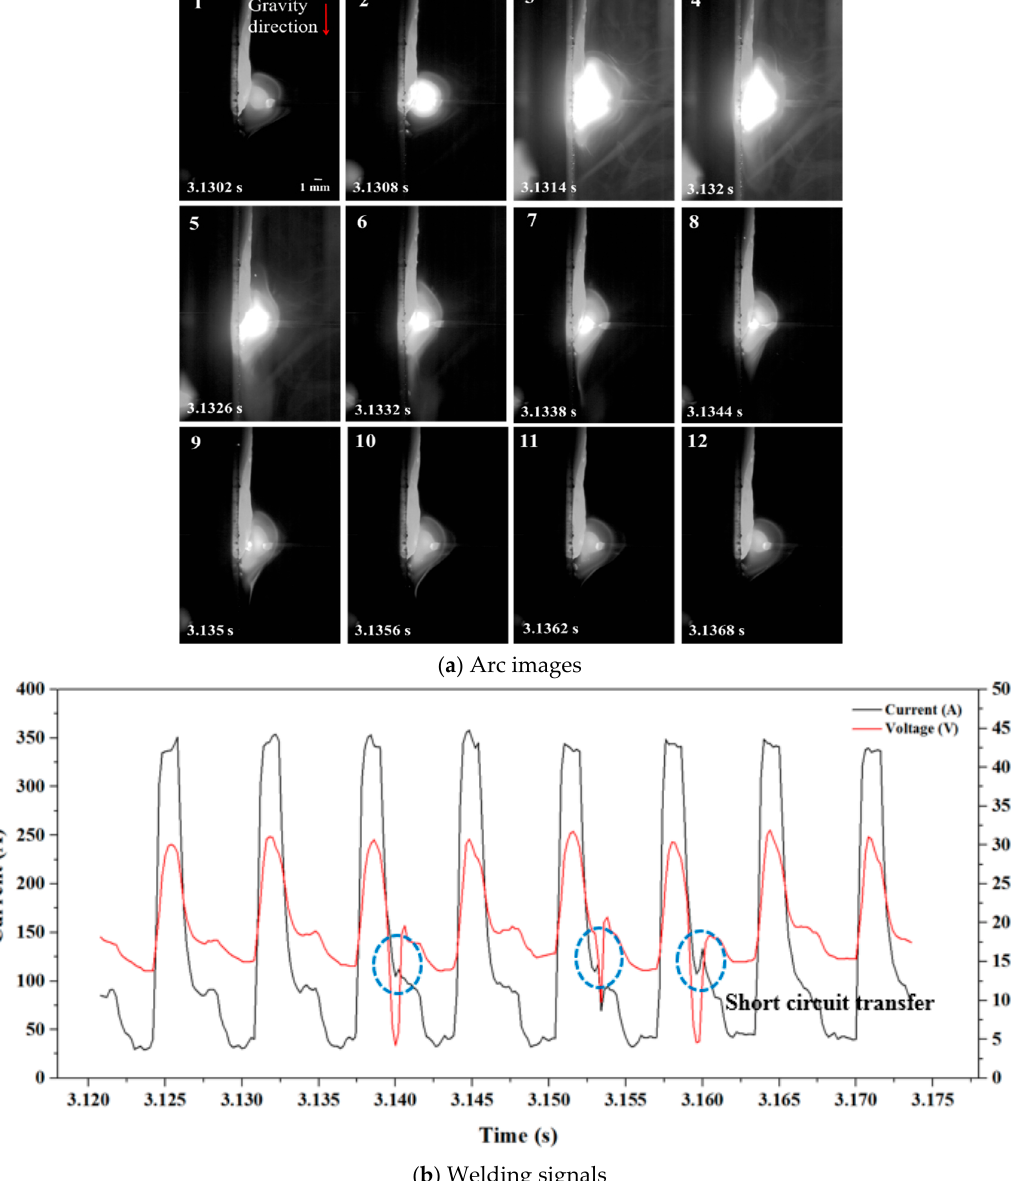
Figure 8. Synchronization of ( a ) arc images and ( b ) welding signals in vertical down position with a WFR of 7 m/min.